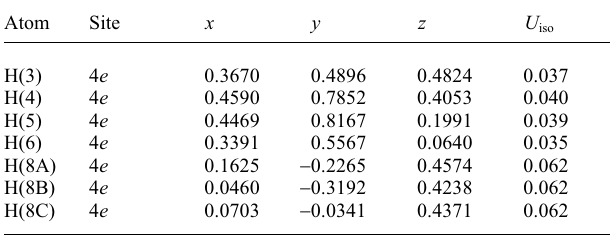
Table 2. Atomic coordinates and displacement parameters (in Å 2 )